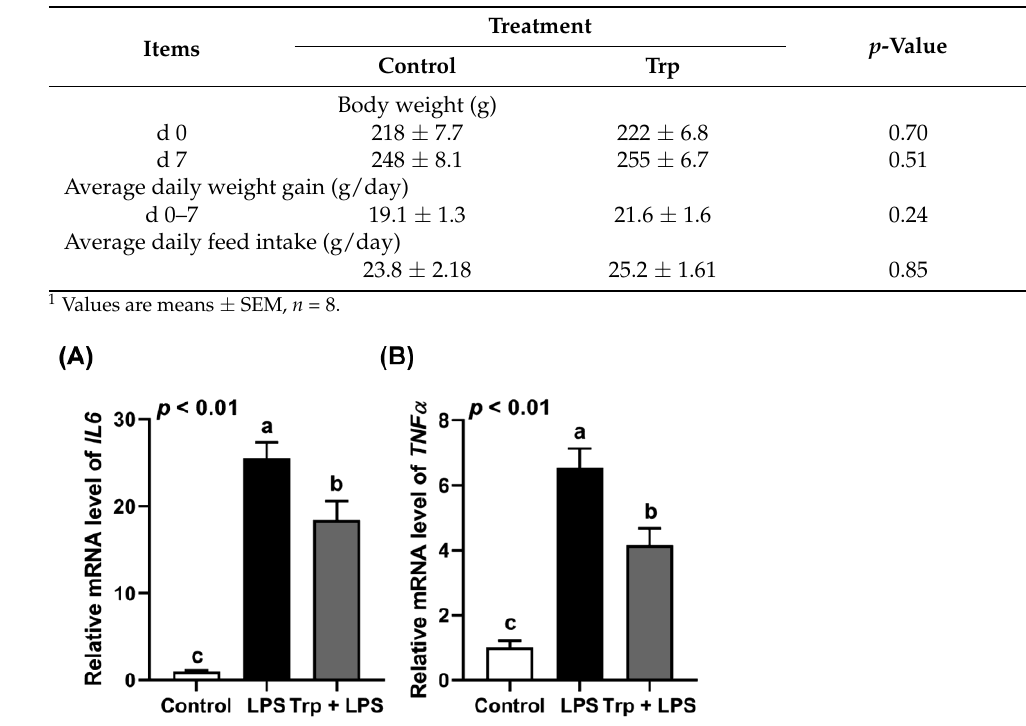
Table 3. Effect of tryptophan supplementation on the growth of rats before LPS challenge 1 .